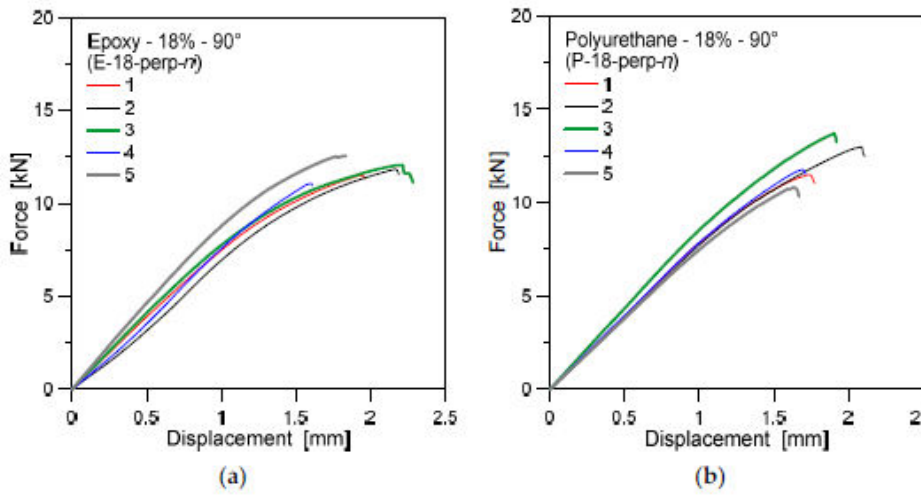
Figure A2. Experimental force–displacement results for specimens with ( a ) epoxy or ( b ) polyurethane glue, under 18% moisture and bonding and perpendicular rod-to-grain